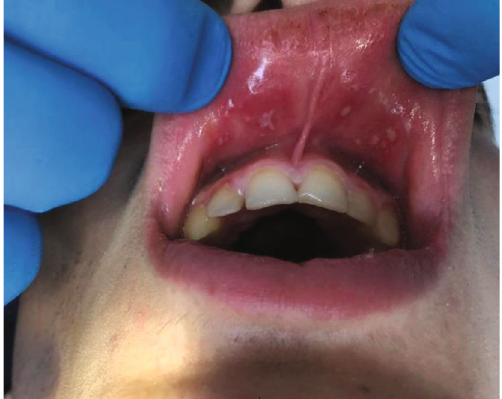
Figure 2: Aphthous ulcers on the mucous membrane of the